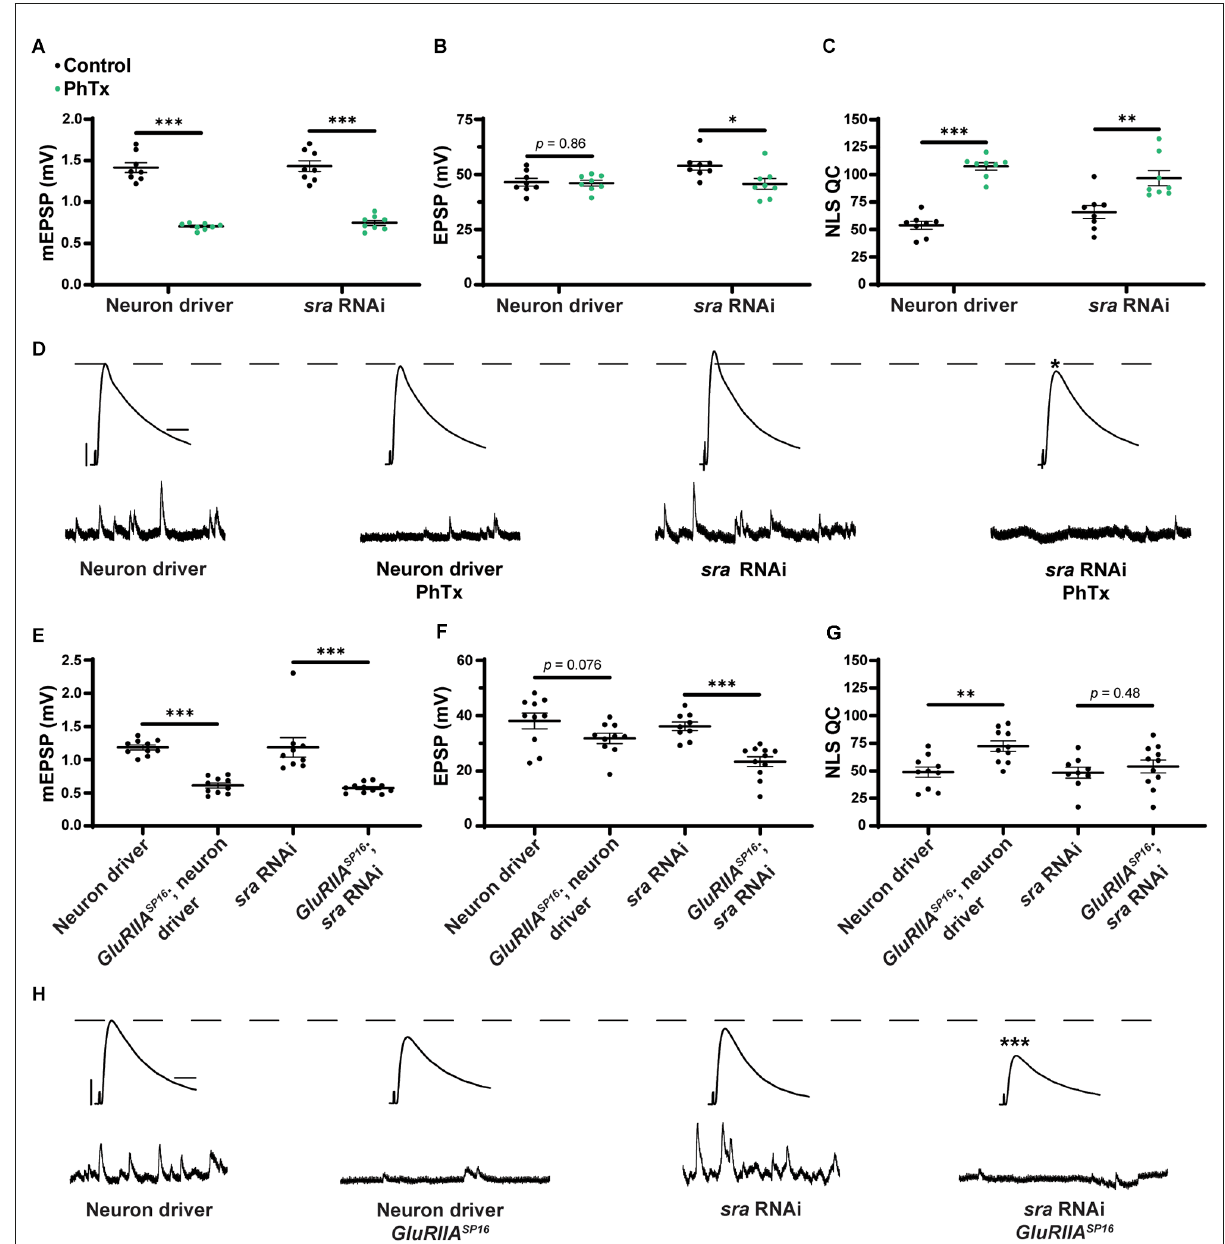
FIGURE7 Maintenance of presynaptic homeostatic potentiation is impaired by neuronal knockdown of sra but acute expression is not. (A–C) Quantification showing average mEPSP amplitude, EPSP amplitude, and NLS quantal content in pre-GAL4 control and pre-GAL4 driven sra RNAi. Black points show DMSO control synapses, while green points show synapses treated with PhTx. (D,H) Representative electrophysiological traces of EPSPs (above) and mEPSPs (below). Scale bars for all traces are y = 10 mV (1 mV), x = 20 ms (500 ms) for EPSPs (mEPSPs). (E–G) Quantification